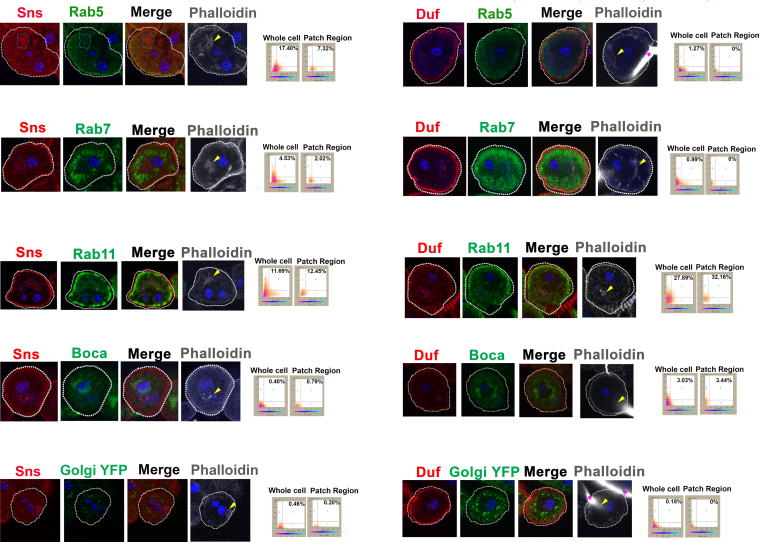
Co-localization of Sns or Duf with organelle markers detected by expression of Rab5GFP, early/sorting endosome (green in DotGal4>UASRab5GFP), Rab7GFP, late endosome (green in DotGal4>UASRab7GFP), Rab11GFP recycling vesicles (green in DotGal4>UASRab11GFP), EYFP-Golgi (green in DotGal4>UASGolgiEYFP) or staining for the ER protein Boca (green in Canton(S)) as indicated. Cells were stained for either Sns (left panels) or Duf (right panels) (red) and counterstained with Phalloidin to detect endogenous actin. Nuclei labelled with DAPI. A single optical slice is shown. Graphs to the right of each set of panels indicate co-localization index for Sns or Duf (red) and the respective organelle marker (green) measured for the entire cell or for the cytoplasmic patch of Sns or Duf only. White dotted line indicates the cell boundary. Blue dotted line indicates Sns or Duf or actin patch as indicated. Phalloidin patch (yellow arrowhead) is shown for reference for each cell, but in some cases is an adjacent slice. Pink asterisk indicates background signal from extracellular material connecting the nephrocytes.